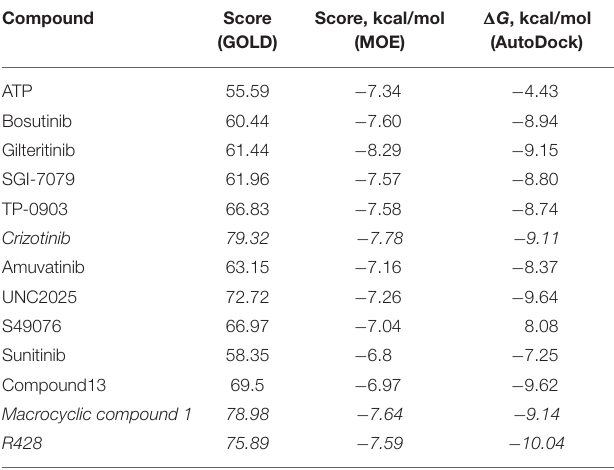
TABLE 2 | The PubChem CID and scores for the top 10 out of 136 R428 analogs according to the docking results performed by the GOLD and MOE software.